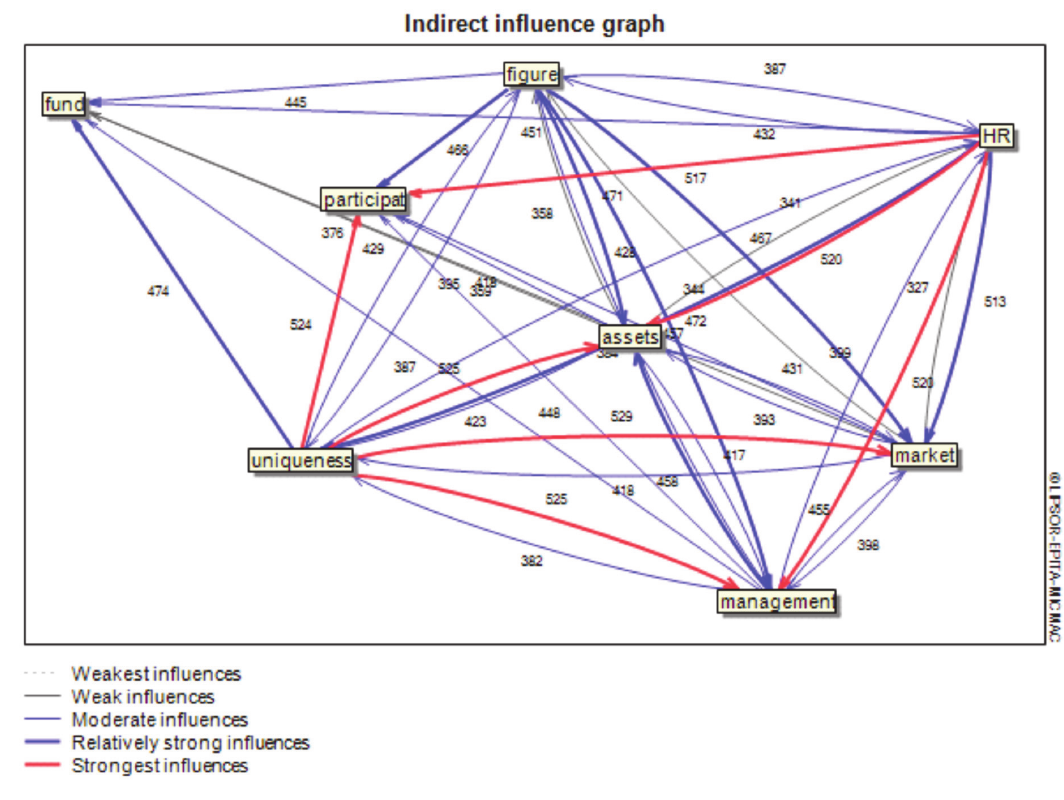
Fig. 6. Relationship of Indirect Effects of Sustainability